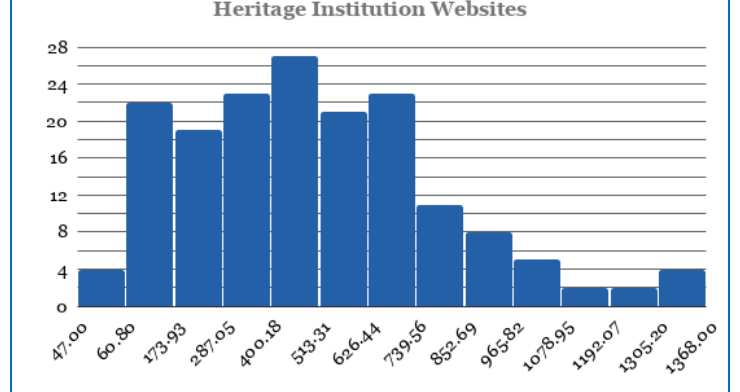
Figure 2. Histogram of the number of images that the examined CHI websites contain. The horizontal axis indicates the numerical amount of images that the examined websites contain. The vertical axis demonstrates how many websites contain from 47 up to 1368 images. It is noted that 408 up to 513 images represented the greatest number of websites, with a sample of 27 of the total 171 domains.